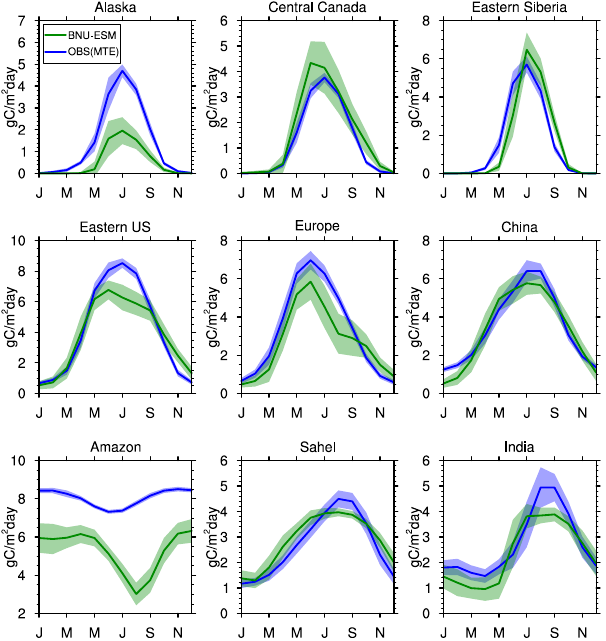
Figure 23. As for Fig. 6, but for GPP for the period 1986–2005. The observations (MTE) are from FLUXNET-MTE estimates (Jung et al.,